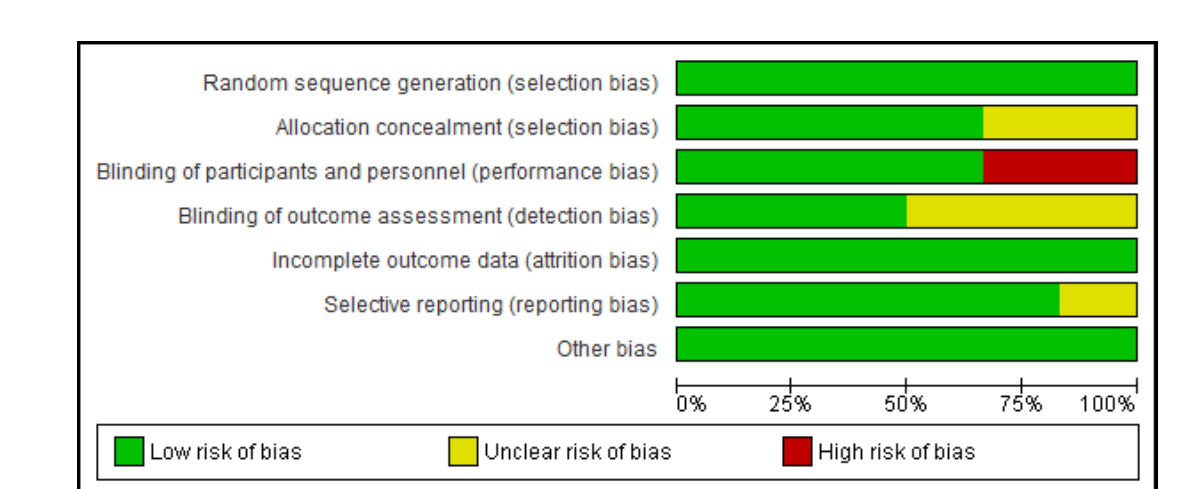
Figure 2. Graph of risk of bias.